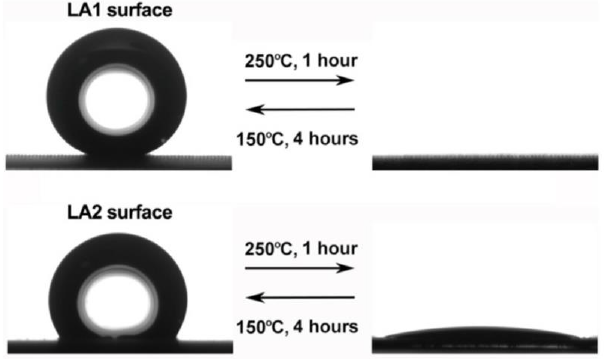
Figure 8. Reversible change of surface wettability by controlling temperature change (Reprinted with permission from Ref. [49]. 2019, Li, X.Y.).